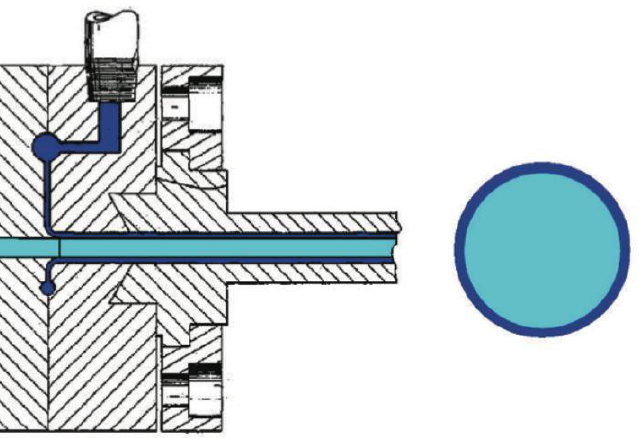
Figure 14. Schema of an encapsulation die (on the left) producing an encapsulated structure (on the right). Adapted from [85].